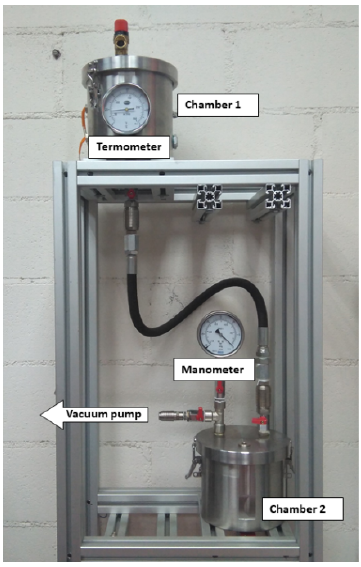
Figure 1. Oil impregnation